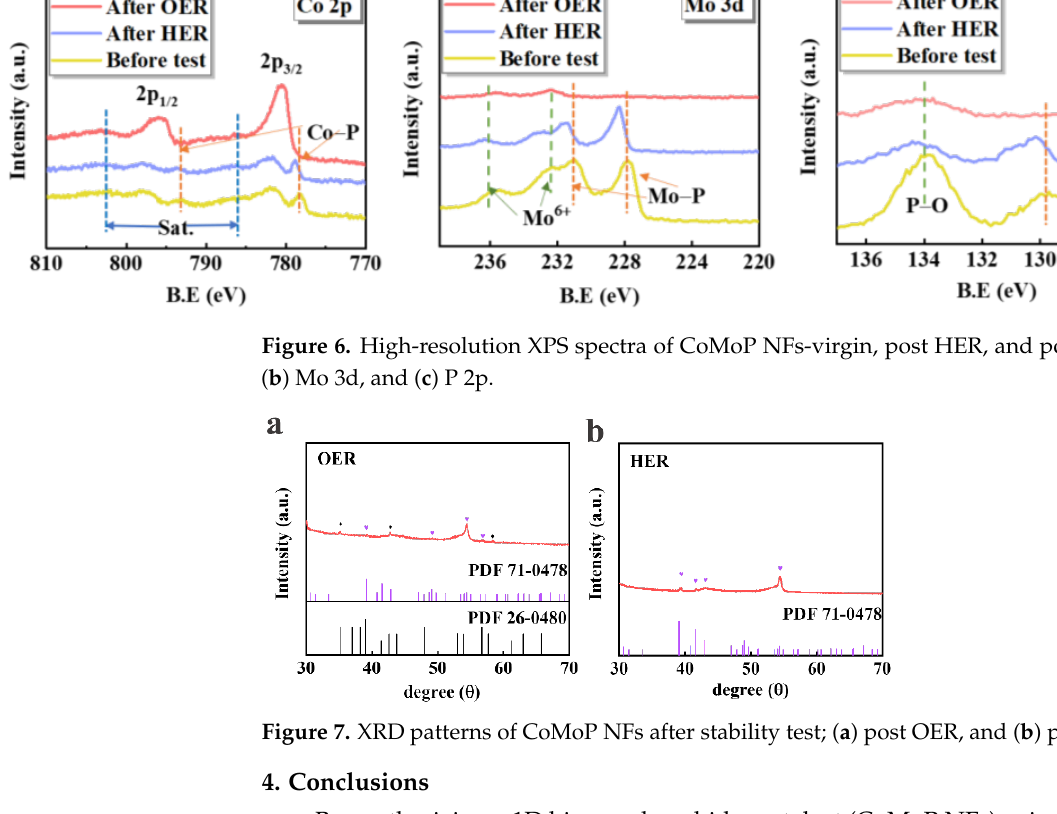
Figure 7. XRD patterns of CoMoP NFs after stability test; ( a ) post OER, and ( b ) post HER.